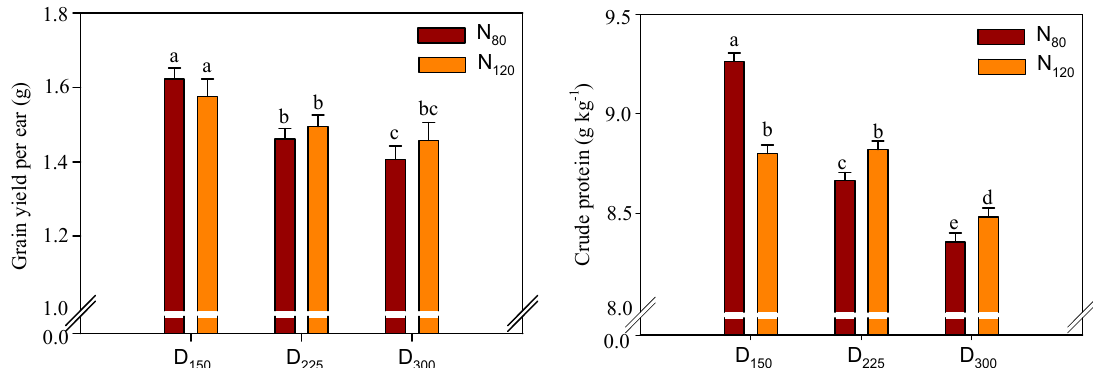
Figure 2. Grain yield per ear and crude protein content depending on seeding density (D) and nitrogen dose (N) (mean ± SD, n = 18). Within each graph, bars marked with different letters are statistically different ( p ≤ 0.05) according to Tukey’s HSD Test.